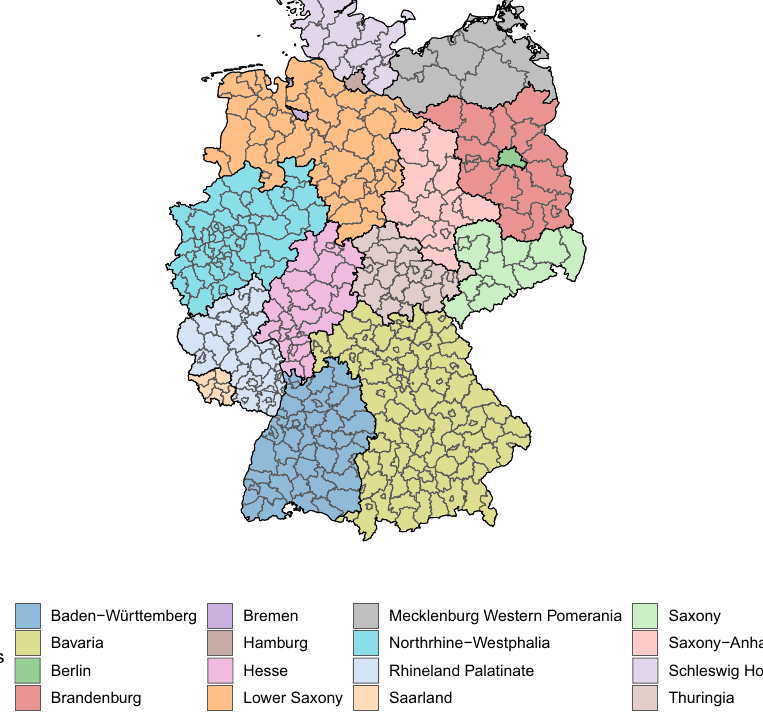
Figure 1. Map of all German federal districts color-coded according to the state they are allocated. The thick black lines indicate borders between federal states, while the thinner grey borders separate federal districts, which is the spatial unit on which the infection data are available. The map was created using the software R 30 with packages sf 31 and ggplot2 32